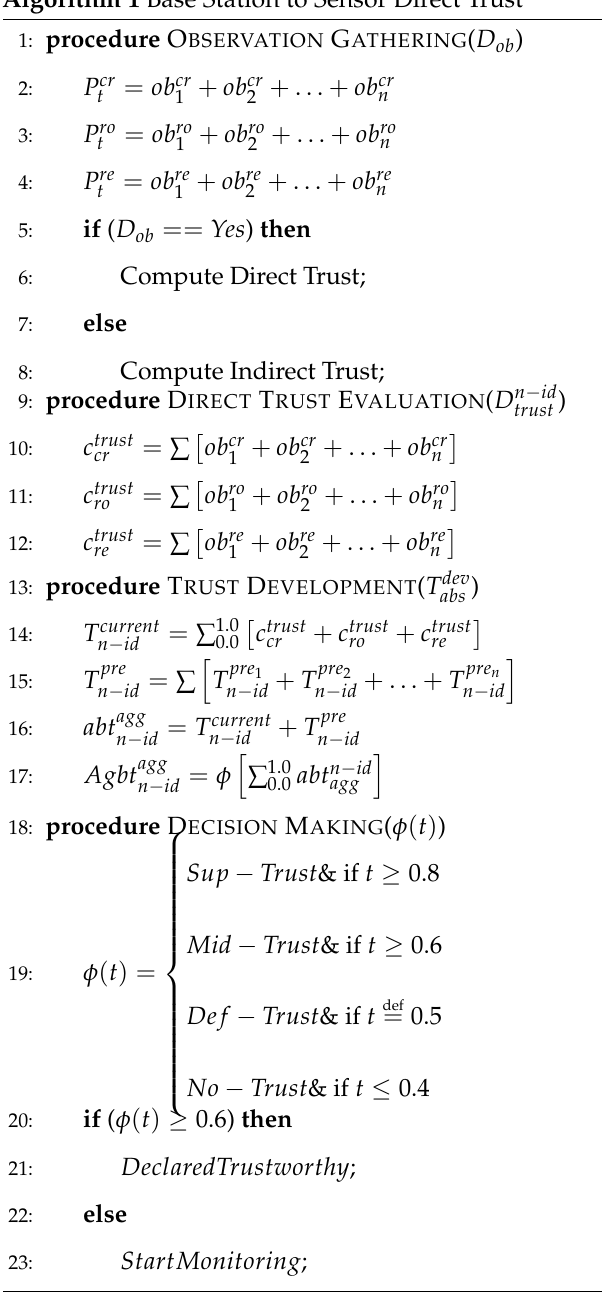
Algorithm 1 Base Station to Sensor Direct